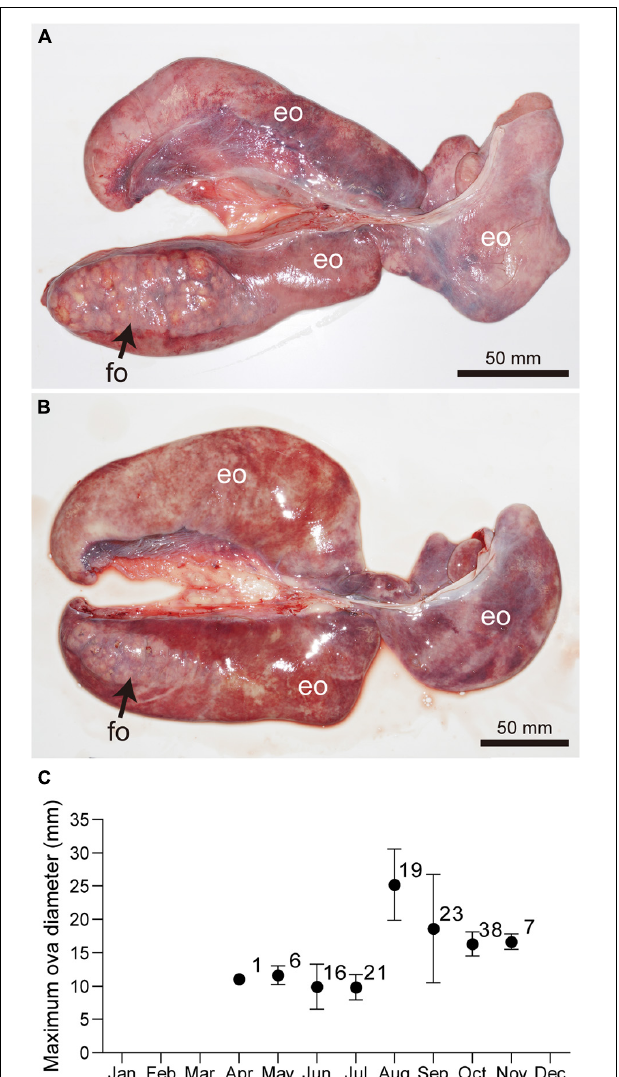
FIGURE 6 | Ovaries of mature females Aetobatus narutobiei before (A) and after (B) ovulation. Only left ovary is functional. (C) Monthly ovarian follicle diameters (mean ± standard deviation and sample size) for mature female Aetobatus narutobiei . The peak of the maximum diameter of the ovarian follicles occurred in August, just prior to ovulation. (eo) epigonal organ, (fo) ovarian